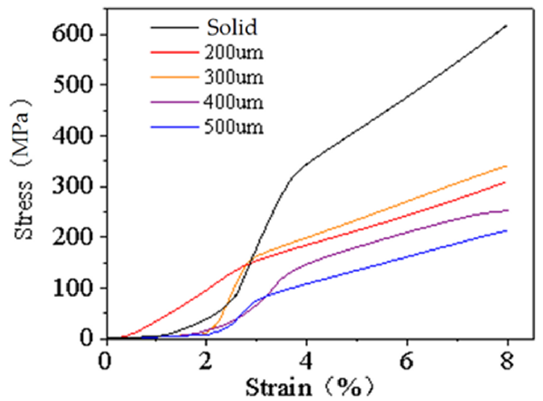
Figure 8. Stress–strain curves of scaffolds with different diameters.